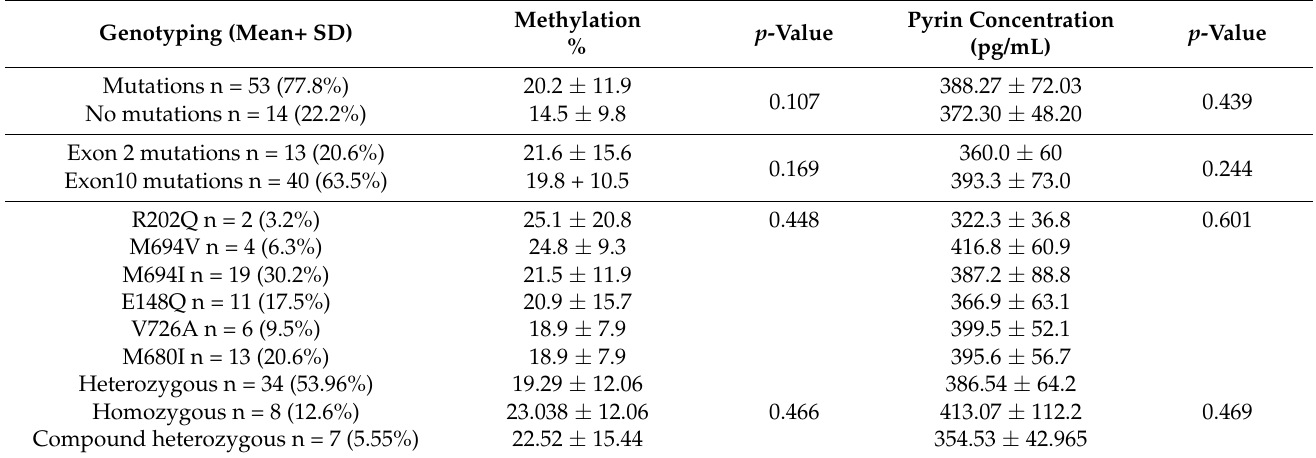
Table 3. Relation of genotypes with MEFV exon 2 methylation% and pyrin concentration in FMF